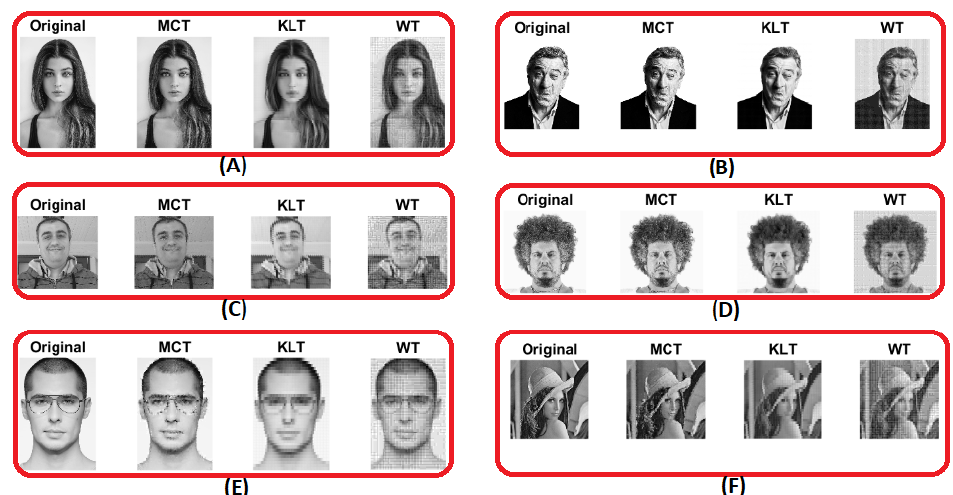
Figure 12. A visual comparative evaluation applied on full image from websites: ( A ) Neutral expression face, ( B ) Screaming face, ( C ) Smiling face, ( D ) Anger face, ( E ) wearing prescription eyeglass, ( F ) Face occlusion by hat.